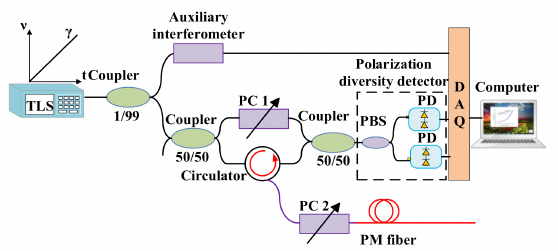
Figure 17. The experimental setup of OFDR for strain and temperature discrimination by PM fiber. TLS is tunable laser source. PC is a polarization controller. PD is a photo-detector. PBS is a polarization beam splitter and DAQ is a data acquisition card. Auxiliary interferometer provides the external clock for DAQ. This figure is adapted from Li et al. [50].